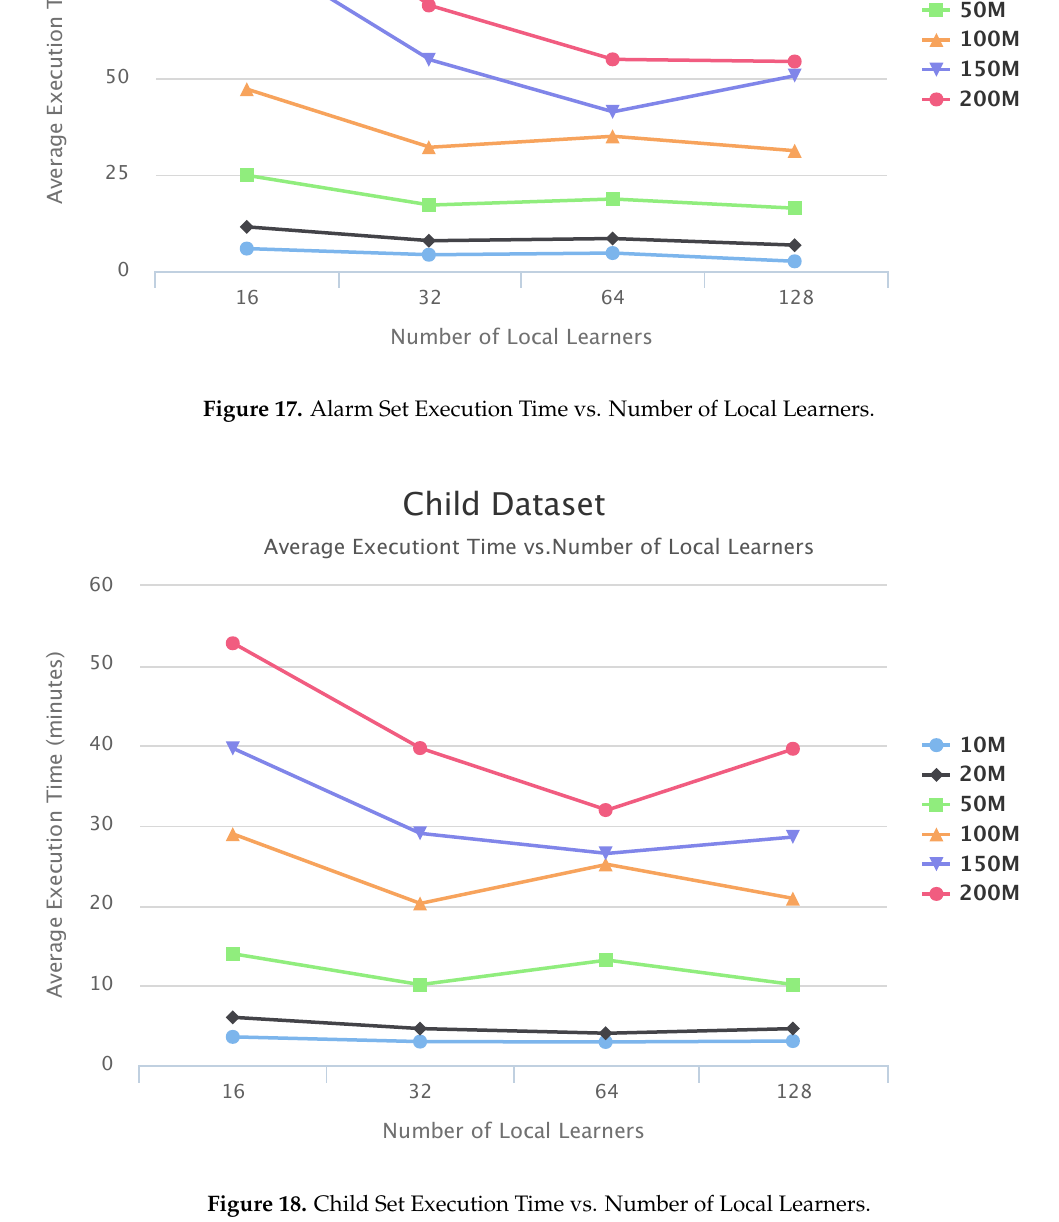
Figure 18. Child Set Execution Time vs. Number of Local